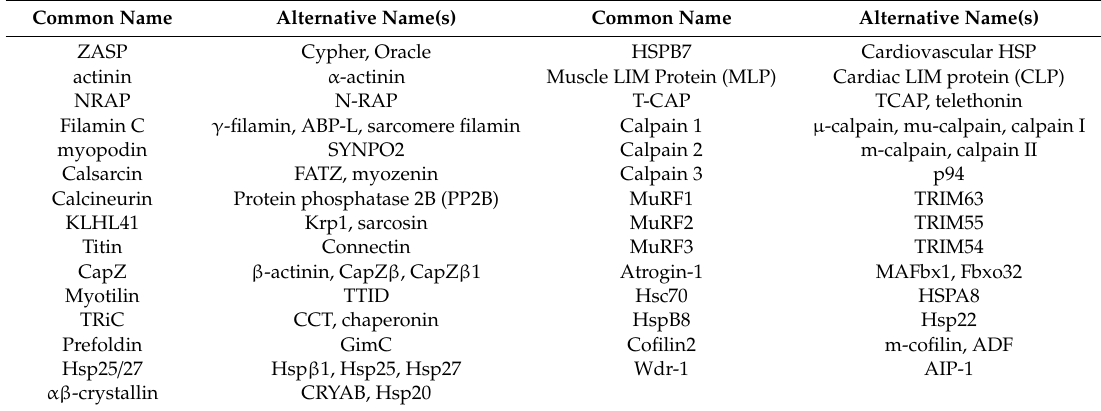
Table 1. Alternative names for sarcomere thin filament